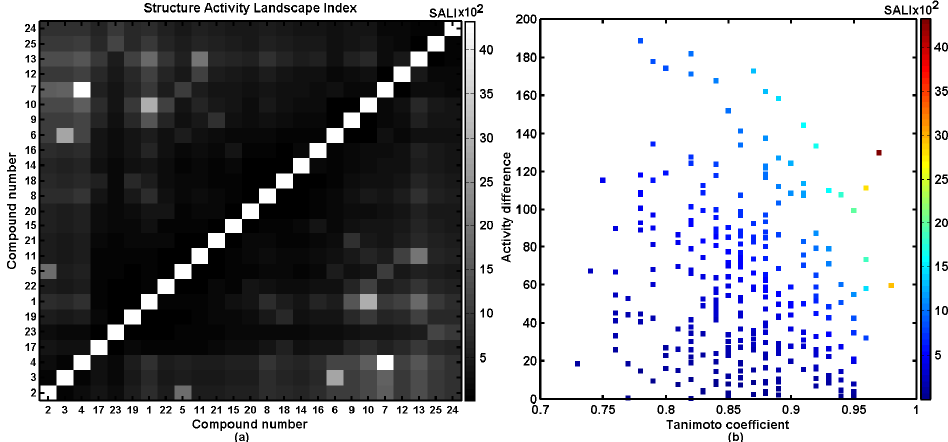
Figure 5. The gray-scaled structure–activity landscape indexes (SALI) plot with compounds ordered by increasing BChE activity ( a ), and a neighboring plot ( b ) for silicon-based carbamates 1 – 25 .